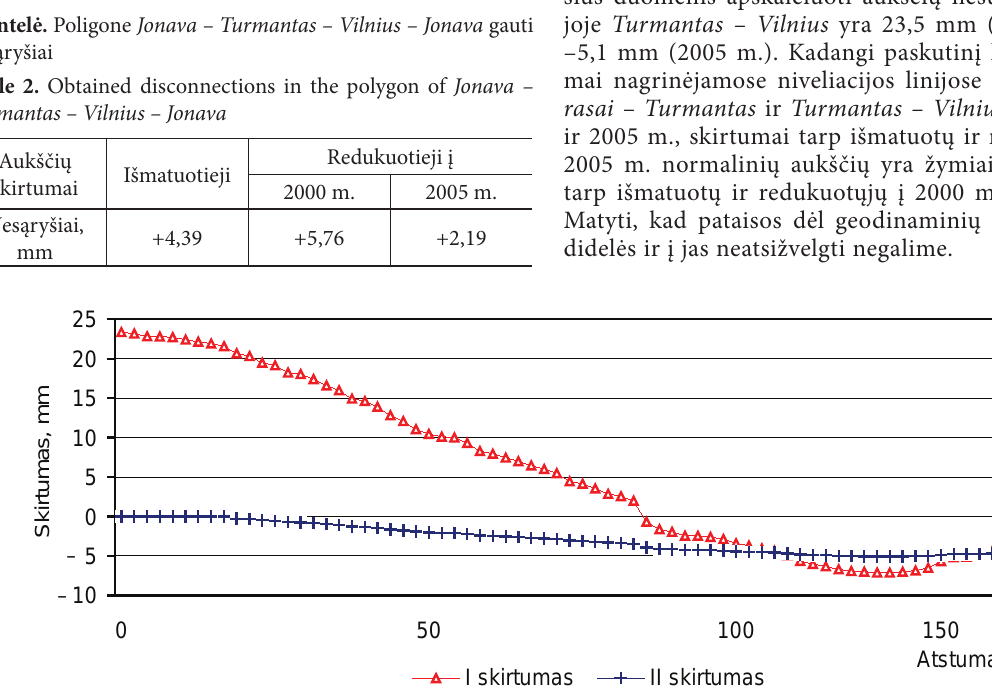
Fig. 3. Difference between the measured and correspondingly reduced into 2000 (1 st difference) and 2005 (2 nd difference) normal altitudes in the levelling line of Turmantas –